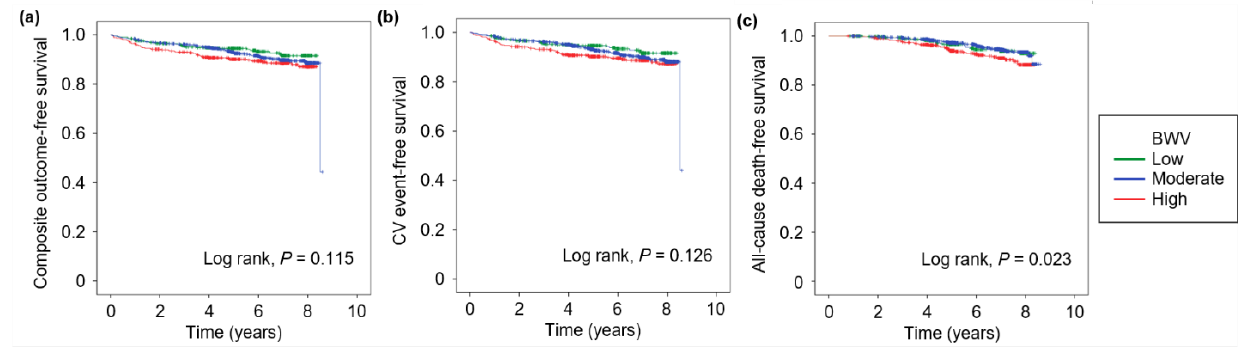
Figure 2. Kaplan–Meier survival curve for the outcomes by BWV. The probability of composite outcome- ( a ), fatal and non-fatal CV event- ( b ), and all-cause death- ( c ) free survivals by BW variability. p values by Log rank test. Abbreviations: BWV, body weight variability; Q1, 1st quartile; Q2, 2nd quartile; Q3, 3rd quartile; Q4, 4th quartile. Table 2. Cox proportional hazards regression of BWV for the outcomes.